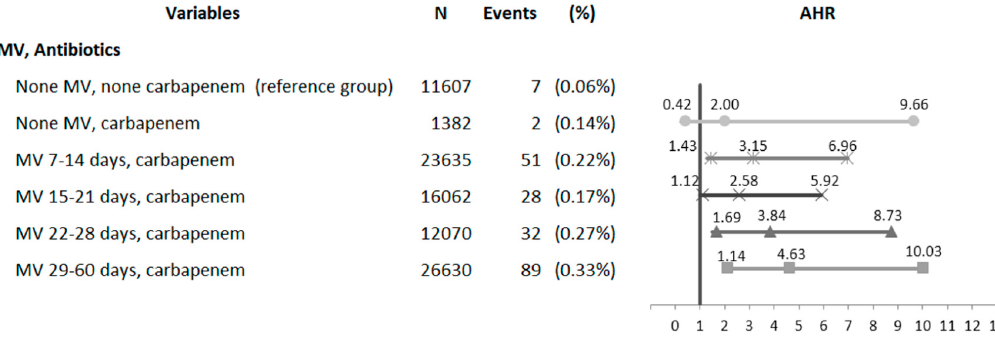
Figure 2. Forest plot of interacted results for the risk of C. difficile infection between the mechanical ventilation support and carbapenem therapy in critically ill ICU patients.